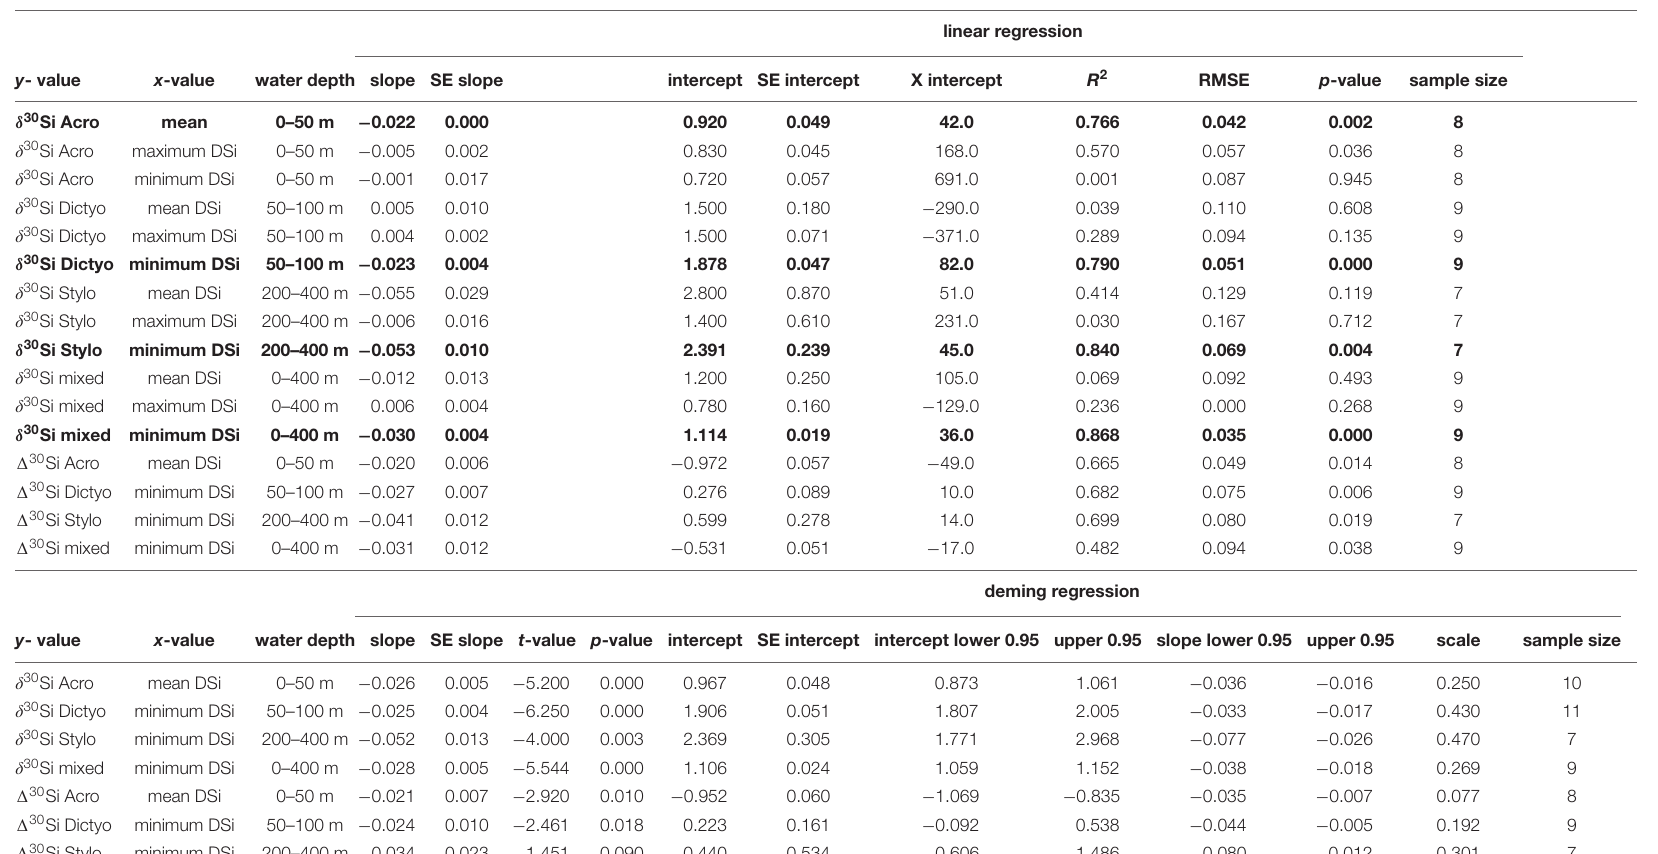
TABLE 3 | Comparison of linear regression and Deming regression results for the different radiolaria species and their respective δ 30 Si and (cid:49) 30 Si with different DSi concentrations of Peru.